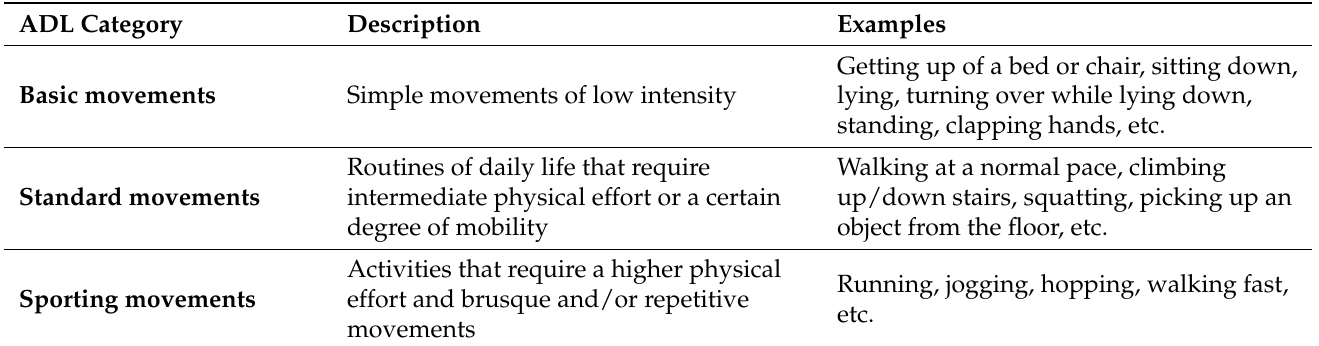
Table 10. Categorization criteria to divide the ADL movements into different